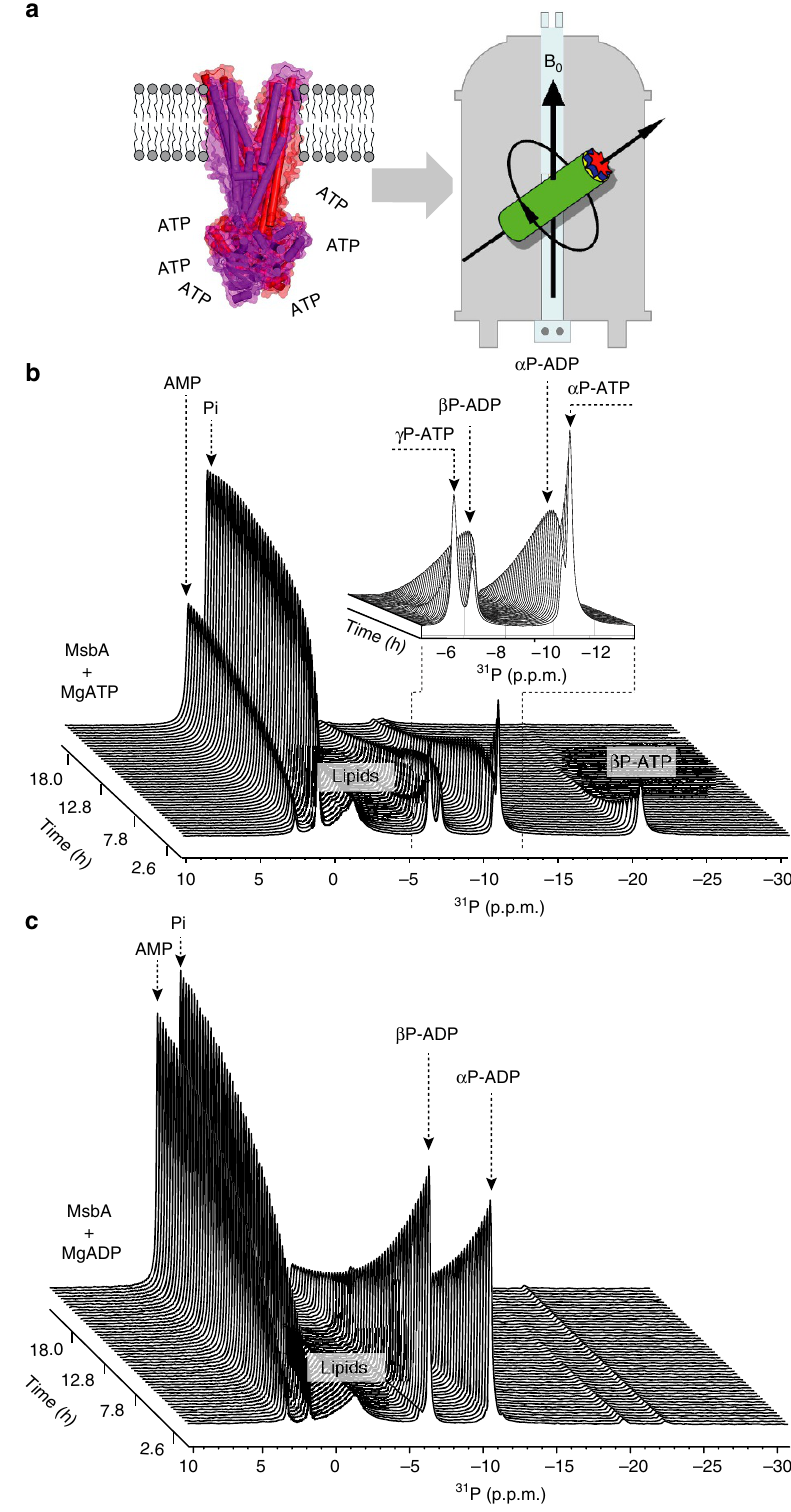
Figure 1 | Probing the catalytic activity of MsbA by real-time 31 P-MAS NMR. ( a ) Schematic experimental setup. MsbA is transferred quickly within the MAS rotor to the NMR magnet after addition of MgATP. The catalytic activity is followed by direct polarization 31 P NMR. ( b ) Time-resolved spectra show the reduction of the ATP peak intensities ( a P, b P and g P at (cid:2) 10.89, (cid:2) 20.48 and (cid:2) 6.22 p.p.m., respectively) and the increase of Pi (1.05 p.p.m.) and AMP (2.52 p.p.m.). The ADP resonance intensities ( a P and b P at (cid:2) 10.68 and (cid:2) 7.4 p.p.m.) follow a biphasic time course with initial increase and subsequent decay (inset). ( c ) Addition of MgADP to MsbA proteoliposomes results in a reduction of the ADP resonances. The ratio of integral peak intensities of Pi/AMP approaches 2:1 in b and 1:1 in c